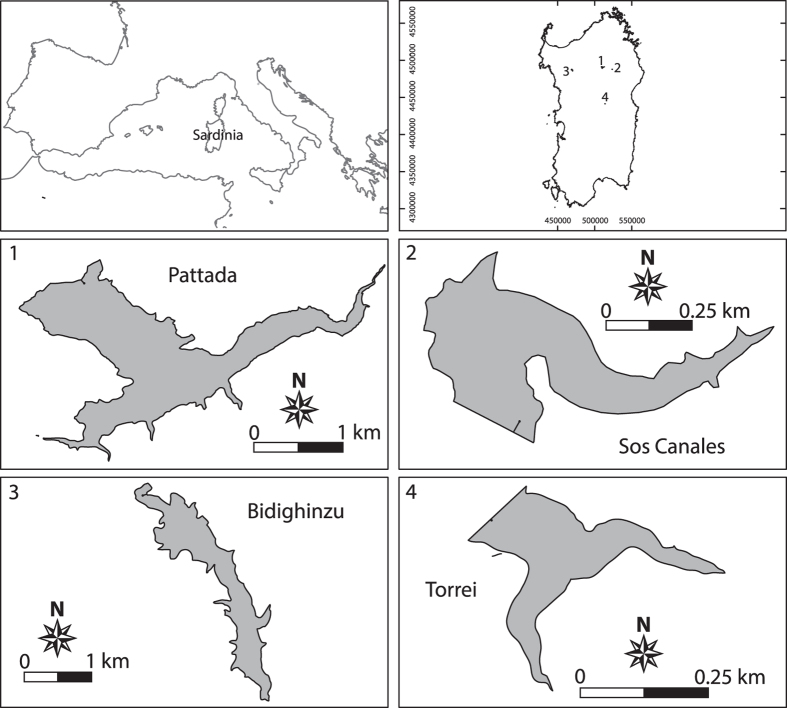
Locations of Sardinian reservoirs and sampling stations.The maps were created and assembled using QGIS software version 2.8.2.